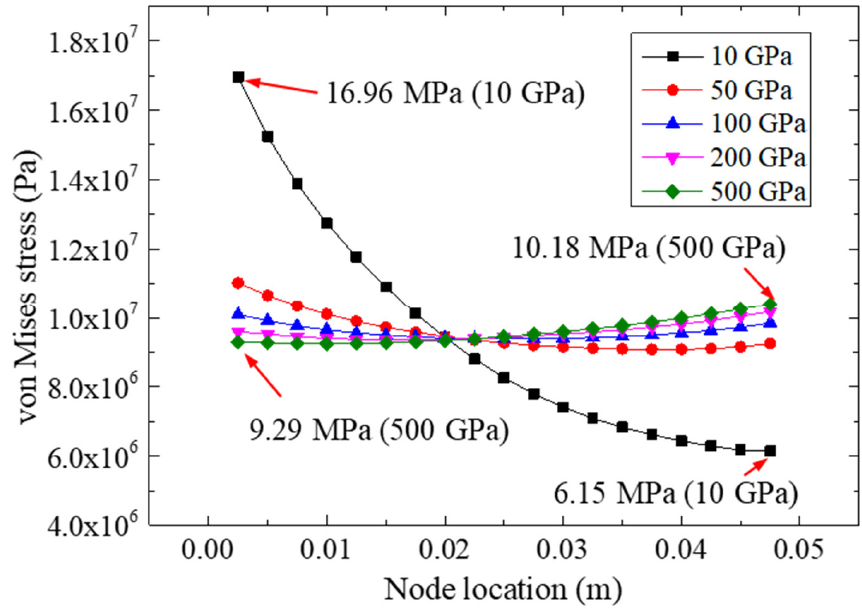
Figure 10. The von Mises stresses on path II for different FRP elastic modulus.